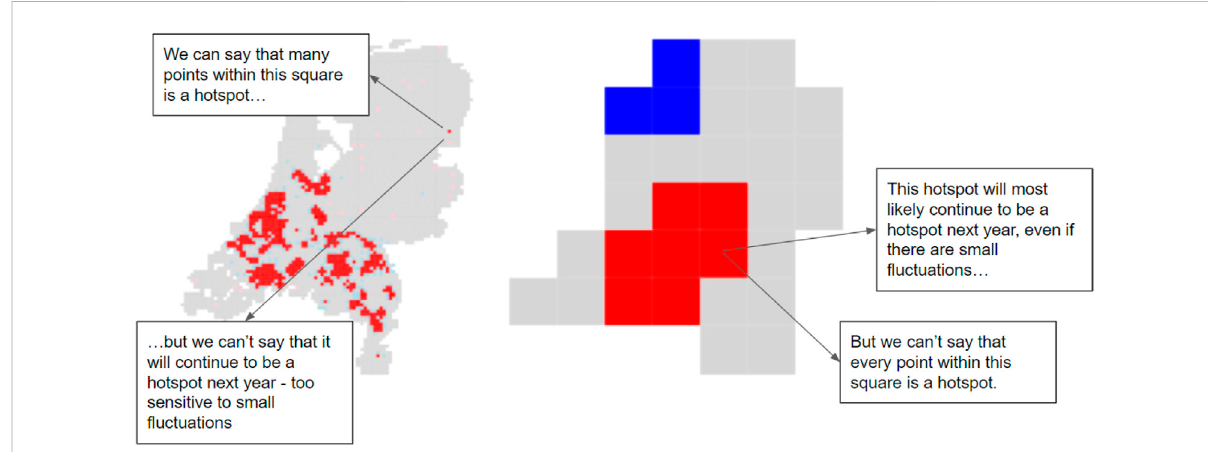
FIGURE 15 Trade off between large and small cell sizes for hot spot mapping. Maps and text boxes created by authors.